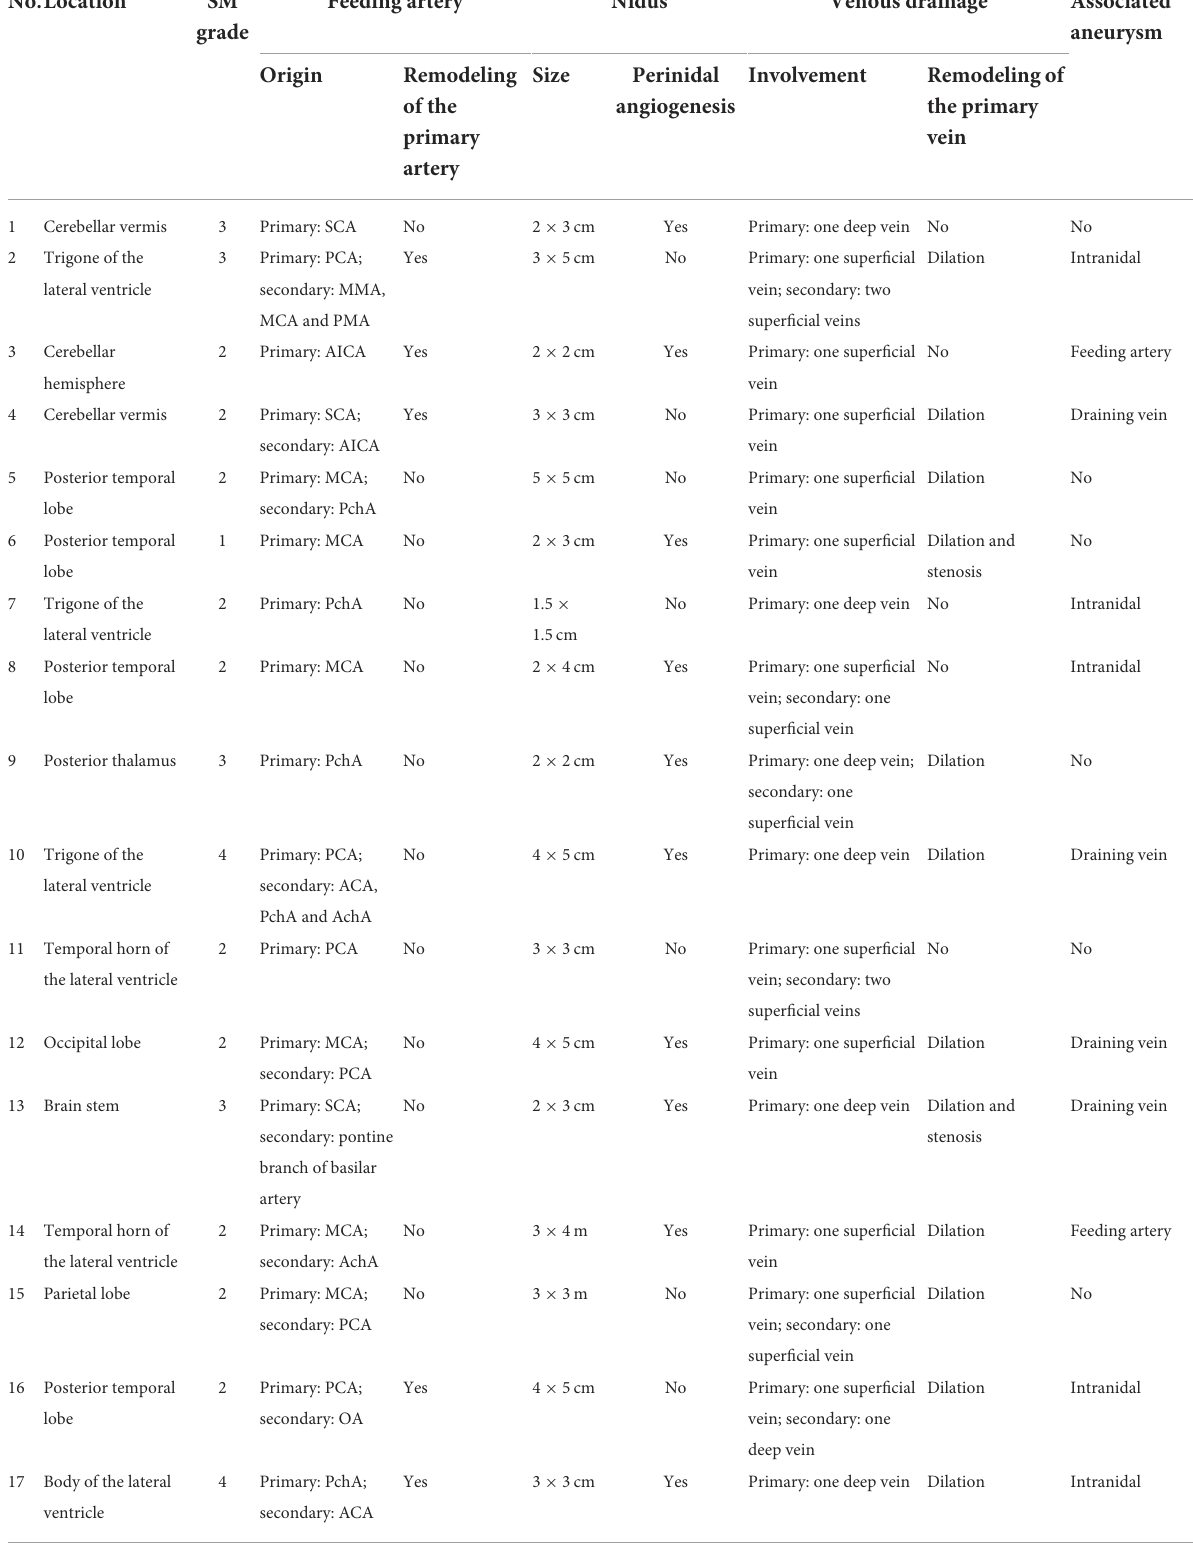
TABLE 2 Angiographic data of the BAVMs. No.Location SM Feeding artery Nidus Venous drainage Associated grade aneurysm Origin Remodeling Size Perinidal Involvement Remodeling of of the angiogenesis the primary artery